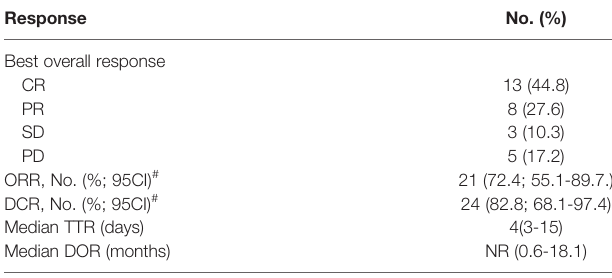
TABLE 1 | Baseline characteristics. TABLE 2 | Treatment